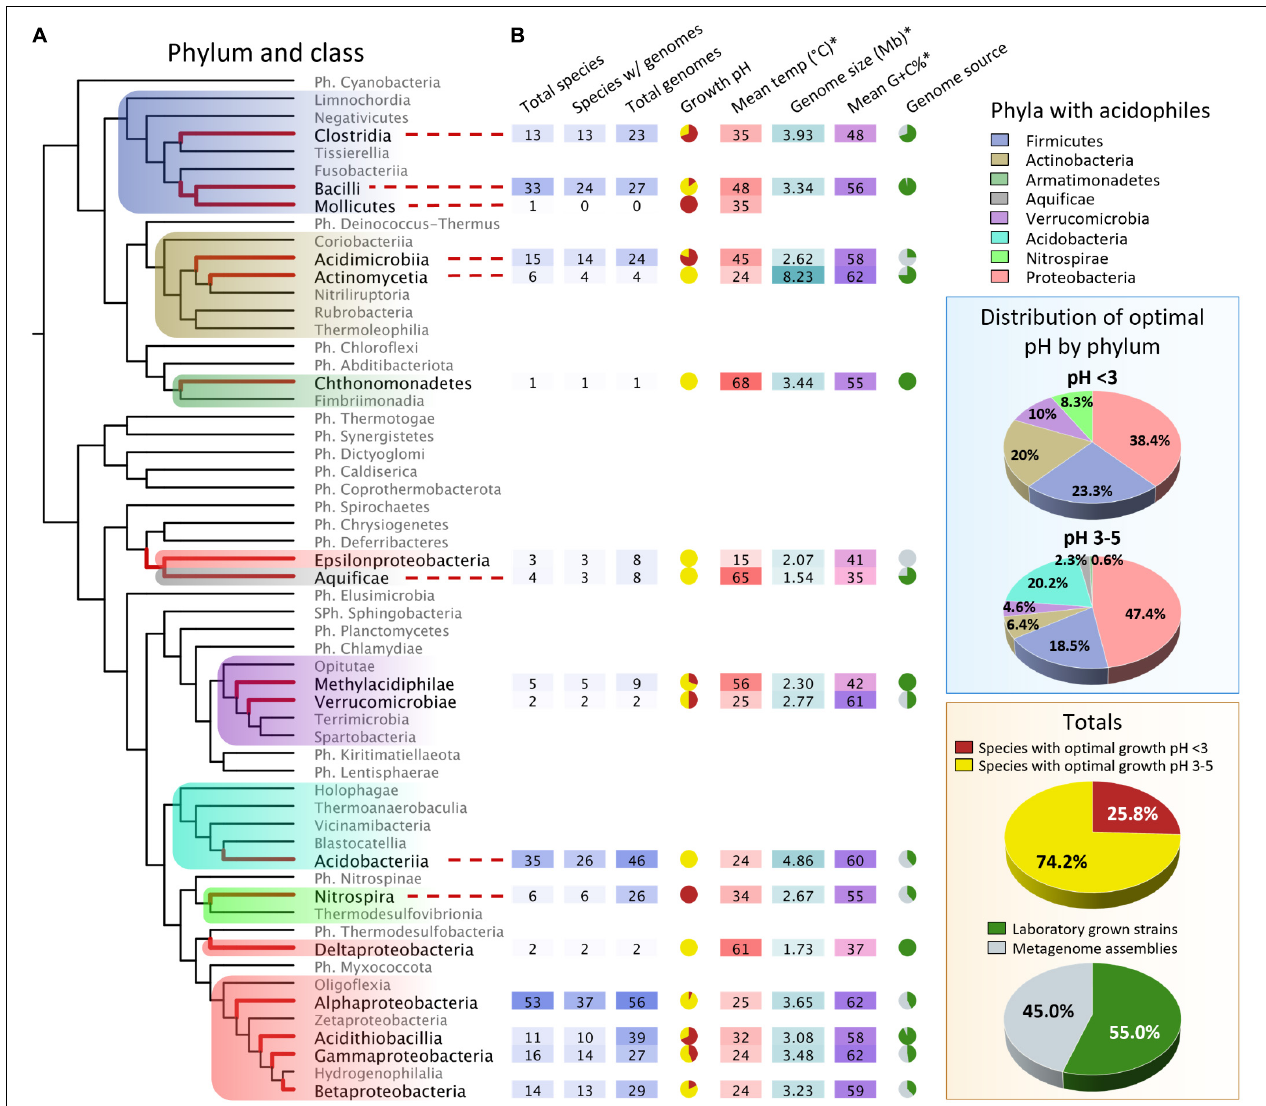
FIGURE 1 | Taxonomic distribution of the acidophilic genomes interrogated. (A) A rooted cladogram displaying the phyla, classes, and metadata of acidophiles with genomic data. The cladogram was constructed using AnnoTree (Mendler et al., 2019) as a guide for phylogenetic positioning and rooted as described by Parks et al. (2018). The phyla with acidophiles were broken down into classes. Lineages with known acidophiles are highlighted, and their branches are shown with thick red lines. (B) Genomic and growth data of the taxa with acidophiles. Dashed lines connect the acidophilic lineages with the taxon’s information when necessary. Growth pH pie charts represent the percentage of species that grow optimally at pH < 3 (red) and at pH 3–5 (yellow). Genome source pie charts represent the percentage of acidophilic genomes sequenced from laboratory pure strains (dark green) vs. metagenome assemblies (gray). (C) Percentage of acidophilic species by phyla for both pH ranges ( < 3 and 3–5). (D) Totals of both pie charts from (B) for all the phyla combined. Ph., phylum; Sph., superphylum. The asterisk indicates the mean values for the acidophiles in the taxon. A more detailed table with the classes’ information can be found in Supplementary Table 3